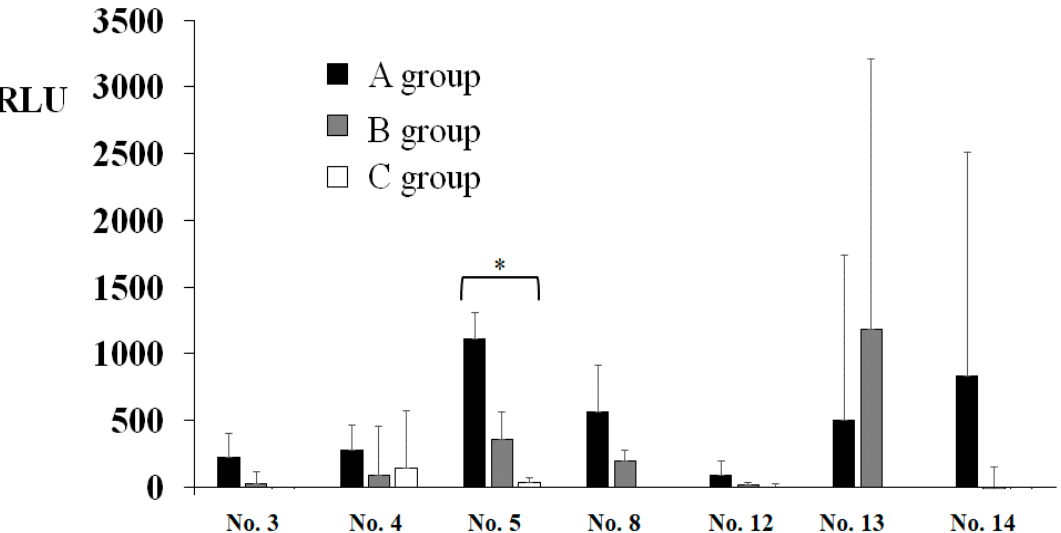
Figure 3. Levels of RLU in droplets and aerosols in various areas around the dental chair. Areas positively detected in A group (None) were selected, and the effects of B group (oral suction), and C group (extraoral and oral suction) on the levels of RLU that indicate luminous activity of ATP to luciferin/luciferase are presented. Locations in No. 3–5, No. 8, and No. 12–14 were indicated in Figure 2. The data indicate the mean ± standard deviation (SD) of three independent experiments. An asterisk indicates a significant difference among the three groups (*: p < 0.05, A–C).